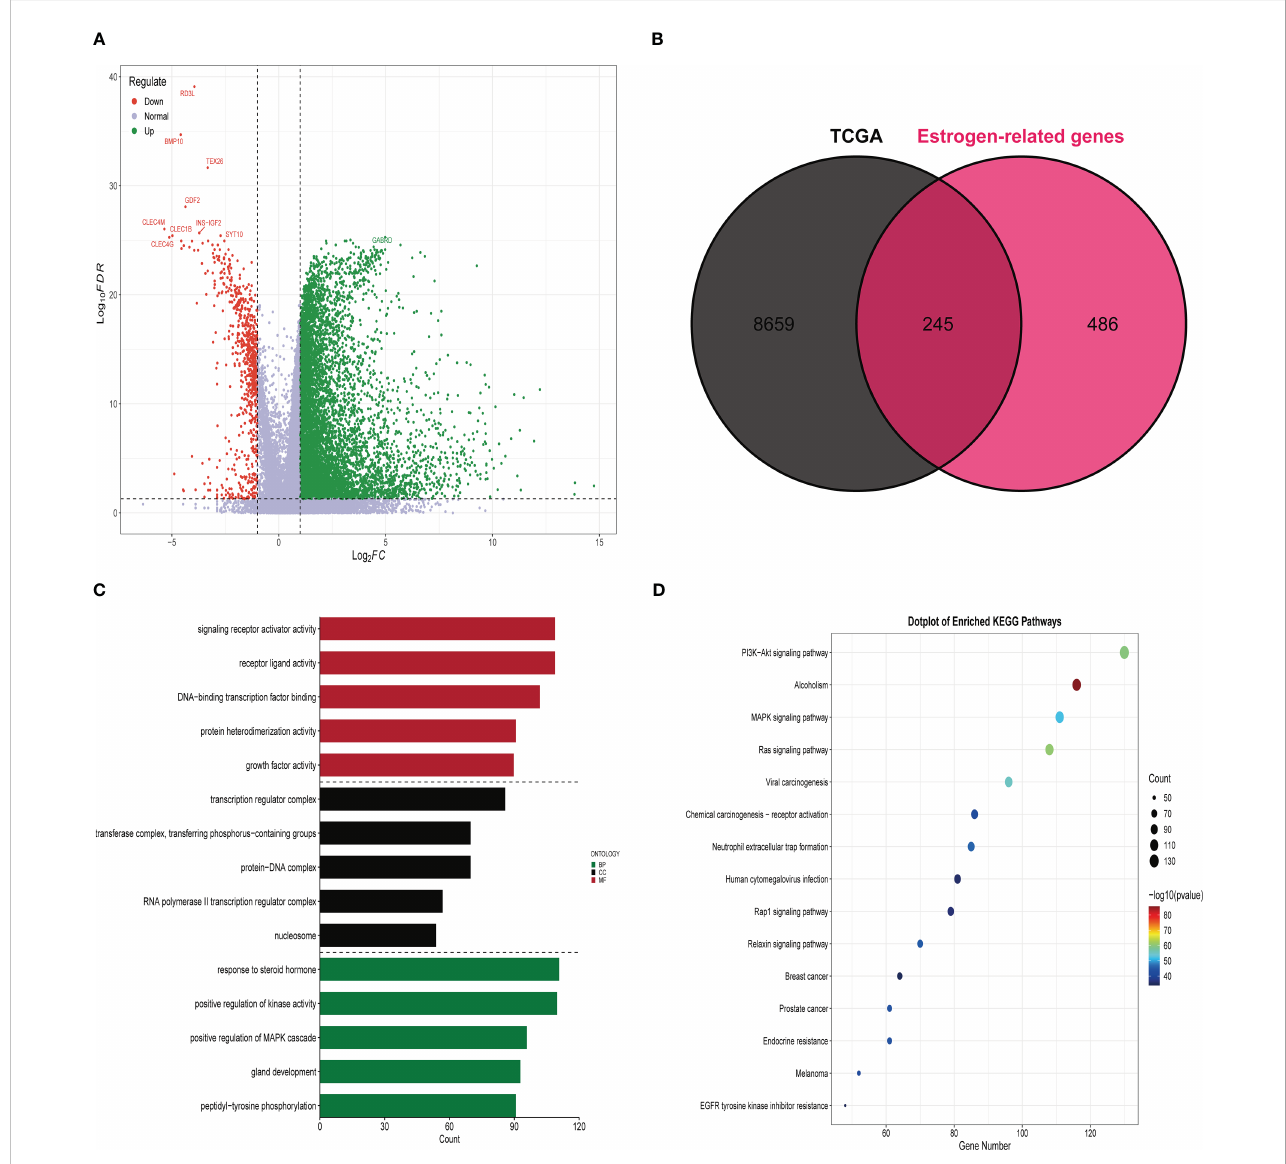
FIGURE 1 Identi fi cation and functional enrichment analysis of differentially expressed estrogen-related genes. (A) The volcano map demonstrates that most genes are highly expressed in HCC tissues compared to paraneoplastic tissues. (B) Venn diagram demonstrating that there are 245 estrogen-related genes differentially expressed in HCC tissue and paracancerous tissue. (C) Results of GO functional enrichment analysis of estrogen-related genes. (D) Results of KEGG functional enrichment analysis of estrogen-related